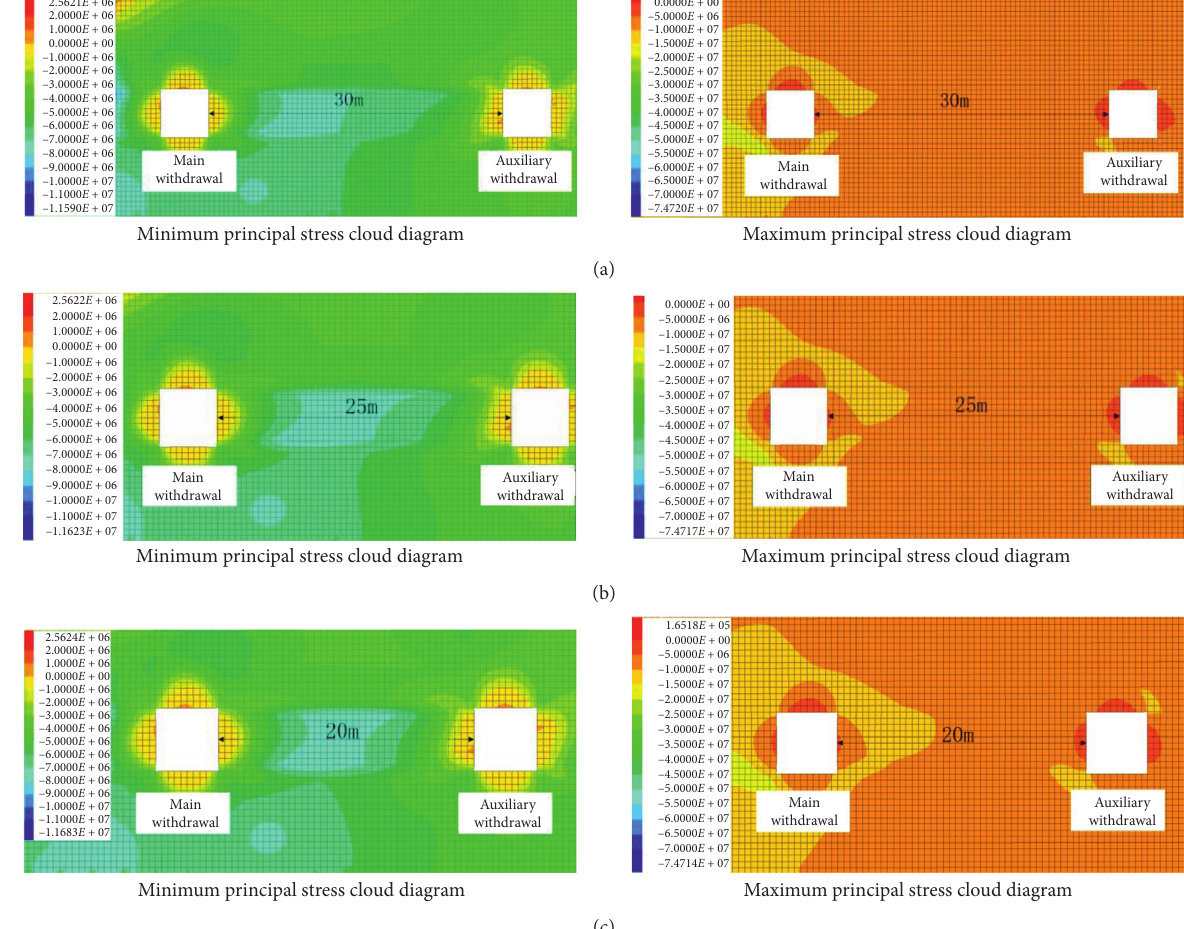
Figure 13: Maximum and minimum principal stress cloud diagrams when Panel 31113 was 15m from penetration. (a) Main and auxiliary withdrawal spacing � 30 m. (b) Main and auxiliary withdrawal spacing � 25 m. (c) Main and auxiliary withdrawal spacing � 20m.